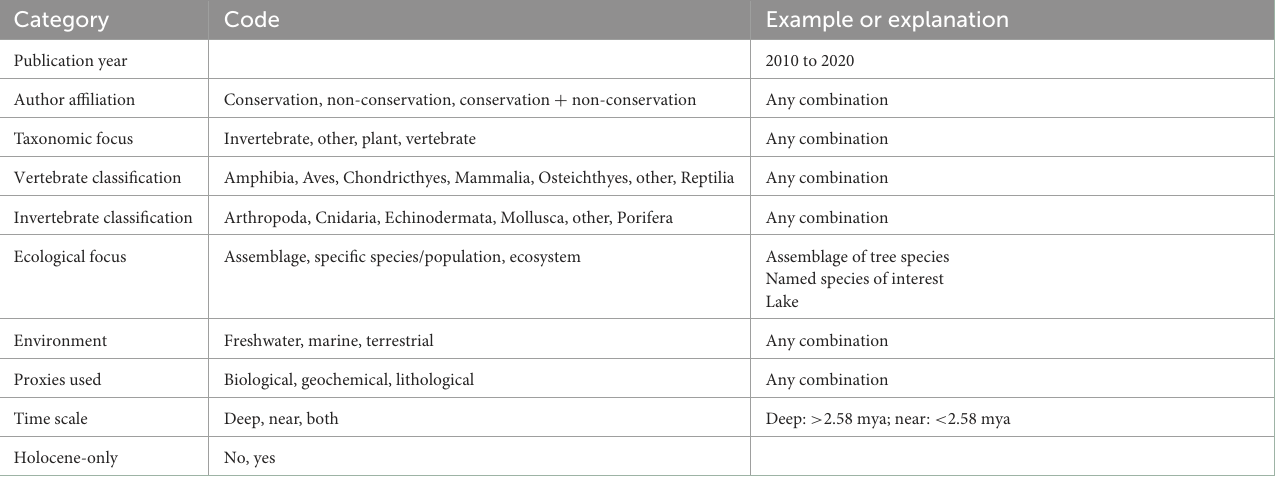
TABLE 1 Categories and coded data collected with an example or explanation.